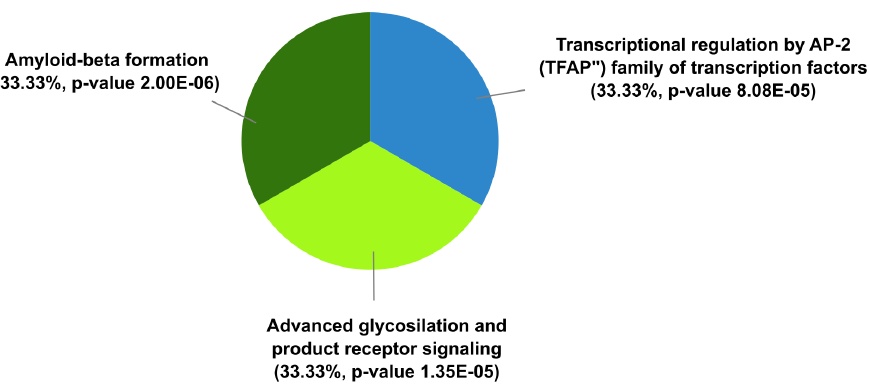
Figure 3: Functional enrichment analysis of the set of 49 interactors likely correlated with phase separation. For each analysis, ClueGO identified a panel of enriched terms (adjusted pValue<0.05) that were clustered. (A) Clusters of enriched terms associated with biological processes involving APE1 likely demixing interactors (Queried databases: WikiPathways [66], KEGG [67], CORUM [68], ClinVar [69], Reactome [70], GOBiologicalProcess [71]). (B) Clusters of enriched terms (adjusted pValue<0.05) associated with subcellular localization are referred to the clusters.